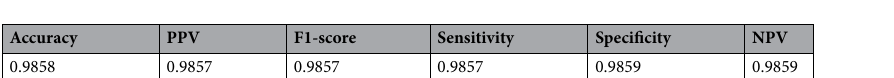
Table 2. The Accuracy, positive predictive value (PPV), F1-score, sensitivity, specificity and negative predictive value (NPV) for the detection of OSCC on